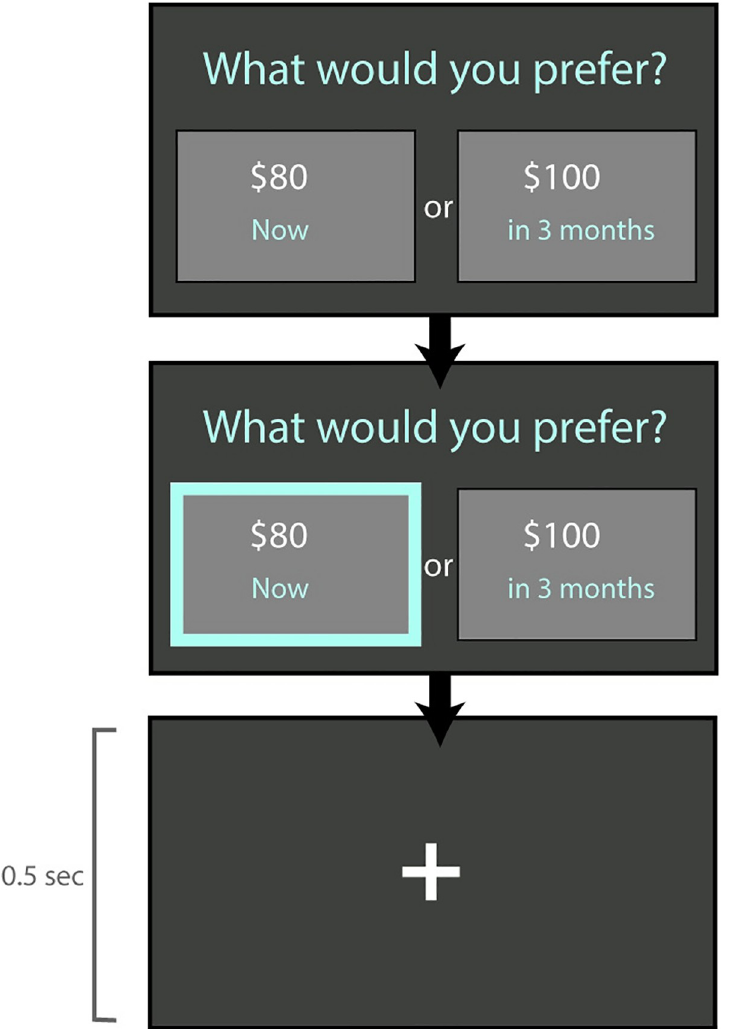
Fig 4. Hypothetical intertemporal choice task. The task required making a series of hypothetical decisions between receiving an amount of money varying between $1 and $99 now or receiving $100 after a delay.